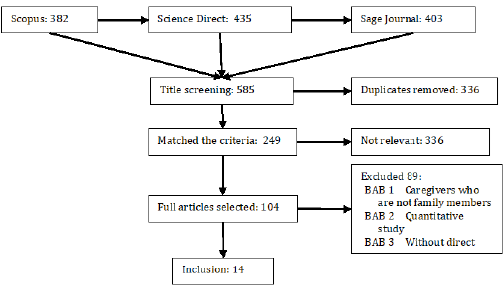
Figure 1. Search tree